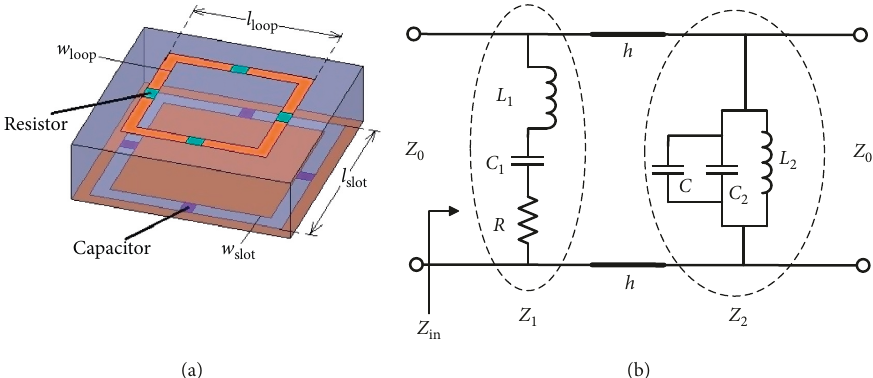
Figure 9: The configuration and equivalent circuit of the miniaturized band-pass FSS with out-of-band absorption. (a) Geometry of one element of the FSS. (b) Equivalent circuit.